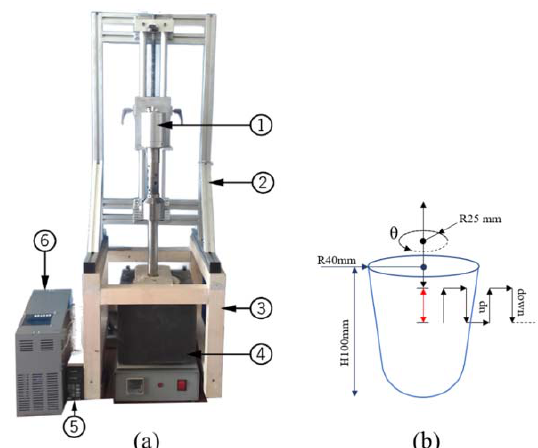
Figure 2. Schematics of ( a ) experimental apparatus: (1) US transducer; (2) and (3) support structure; (4) electric resistance furnace; (5) thermocouple controller; (6) US MMM generator; and ( b ) mechanical stirring process.